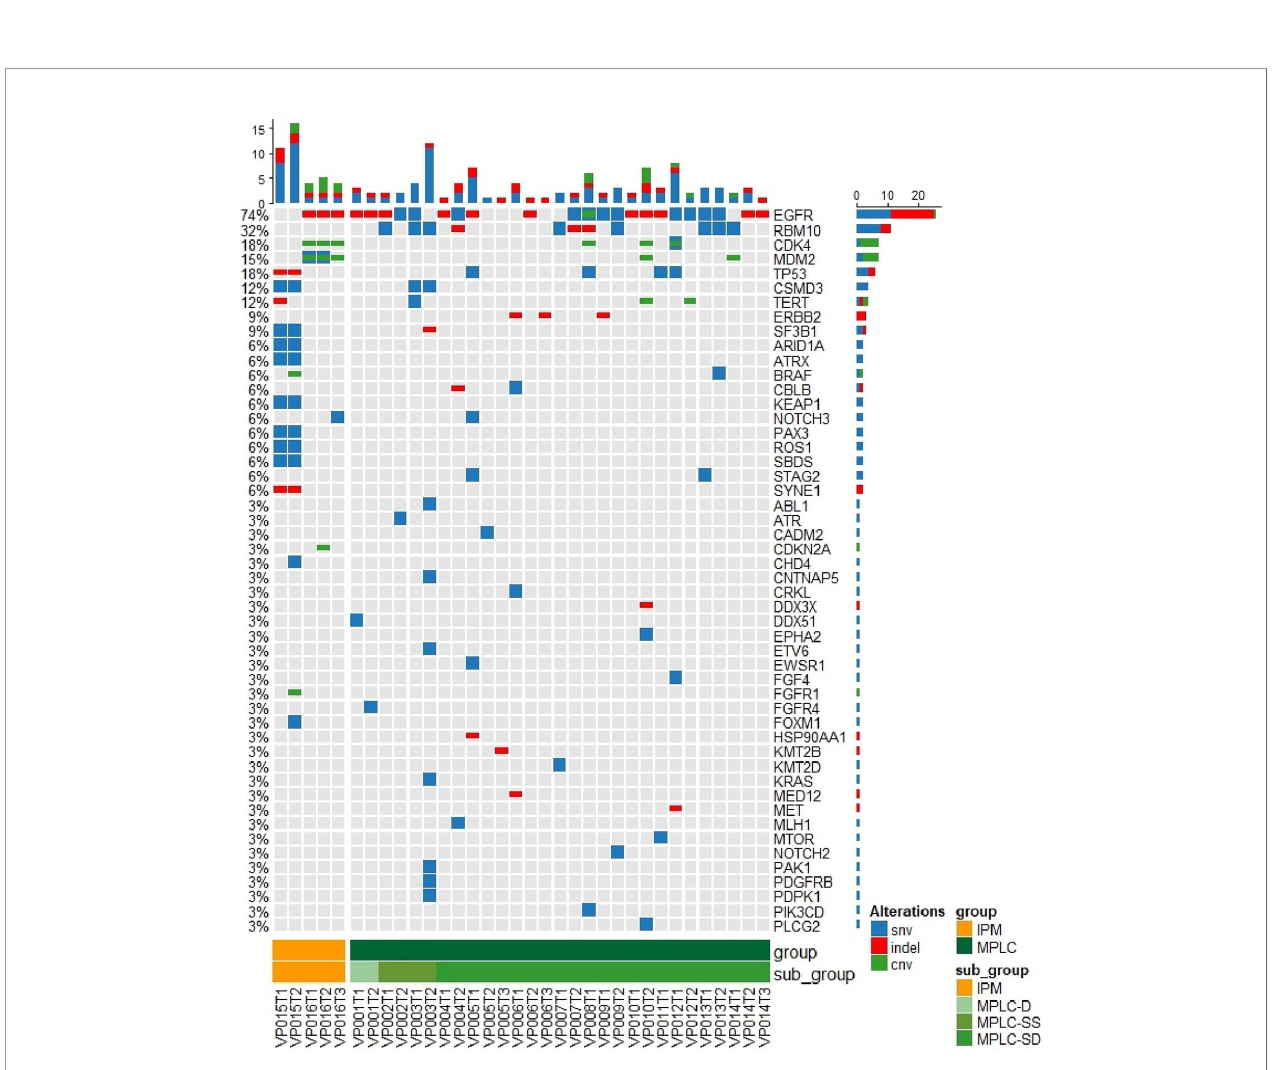
FIGURE 4 | The mutational landscape of all lesions from the validation cohort, including 14 MPLC and 2 IPM patients. The top 50 mutated genes are shown as indicated. Different types of mutations are shown in different colors. MPLC-SD, lesions at the same lung but different lobes; MPLC-SS, lesions at the same lung and same lobe; MPLC-D, lesions at bilateral